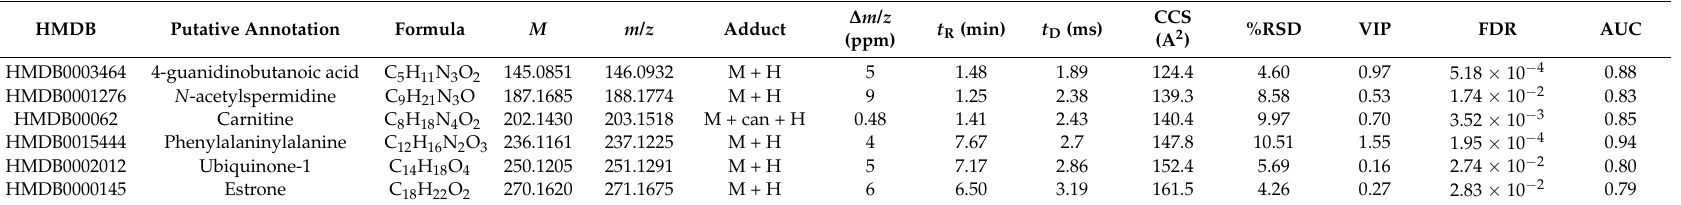
Table 1. Some discriminant putatively annotated features and related statistical